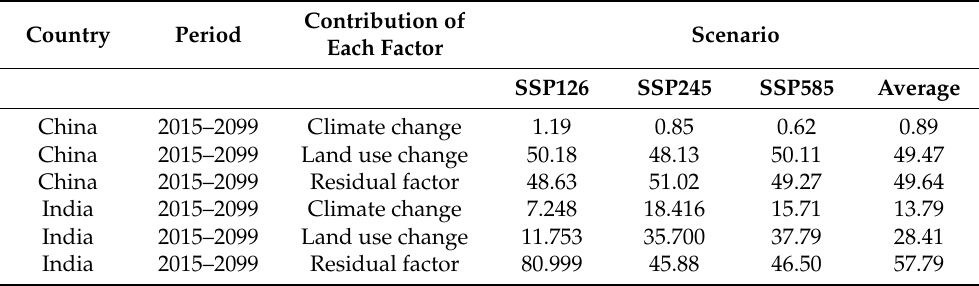
Table 11. Impacts of land use change on photosynthetically active radiation output in China and India. Country